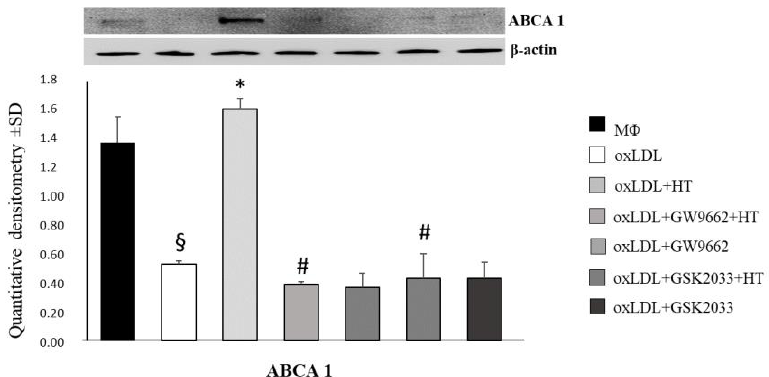
Figure 6. HT influences cholesterol efflux via the PPAR γ /LXR α /ABCA1 pathway. ABCA-1 protein expression in foam cells treated with HT alone or in combination with the PPAR γ and LXR α antago- nists (GW9662 and GSK2033, respectively). Pre-treatment with the antagonists attenuates or abolished the HT-induced upregulation of ABCA-1. § p < 0.05 vs. macrophages (M φ ); * p < 0.05 vs.